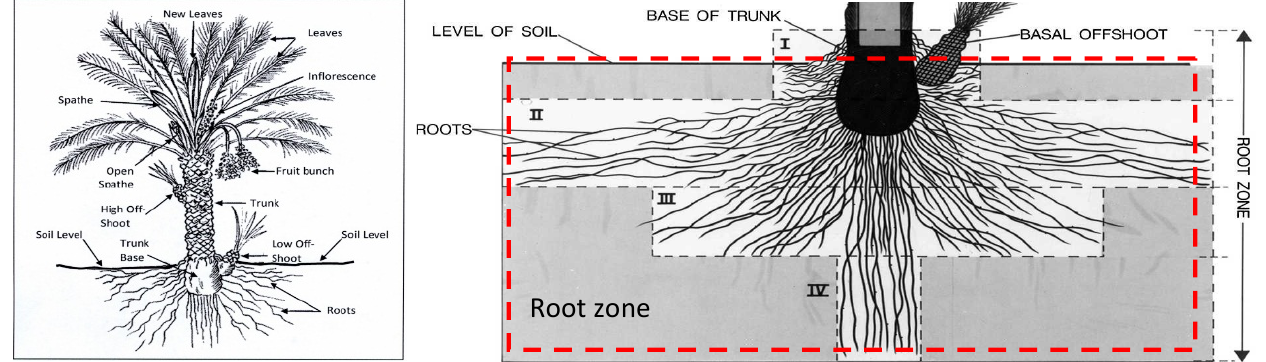
Figure 1: Major parts of the date palm tree (left): root zone, Trunk with off-shoots from the base or along the trunk, and the fronds (leaves). Rootzone divisions (right): zone I: shallow roots emerge from the trunk above the base, less than 25 cm. below the soil level; zone II: intensive rooting up to 100 cm deep; zone III: 100-200cm below surface level, developed based on nutrients availability on above zones; and zone IV: from 200 cm deep on a geotropism orientation searching for water. (Modified from FAO 2016; Barreveld